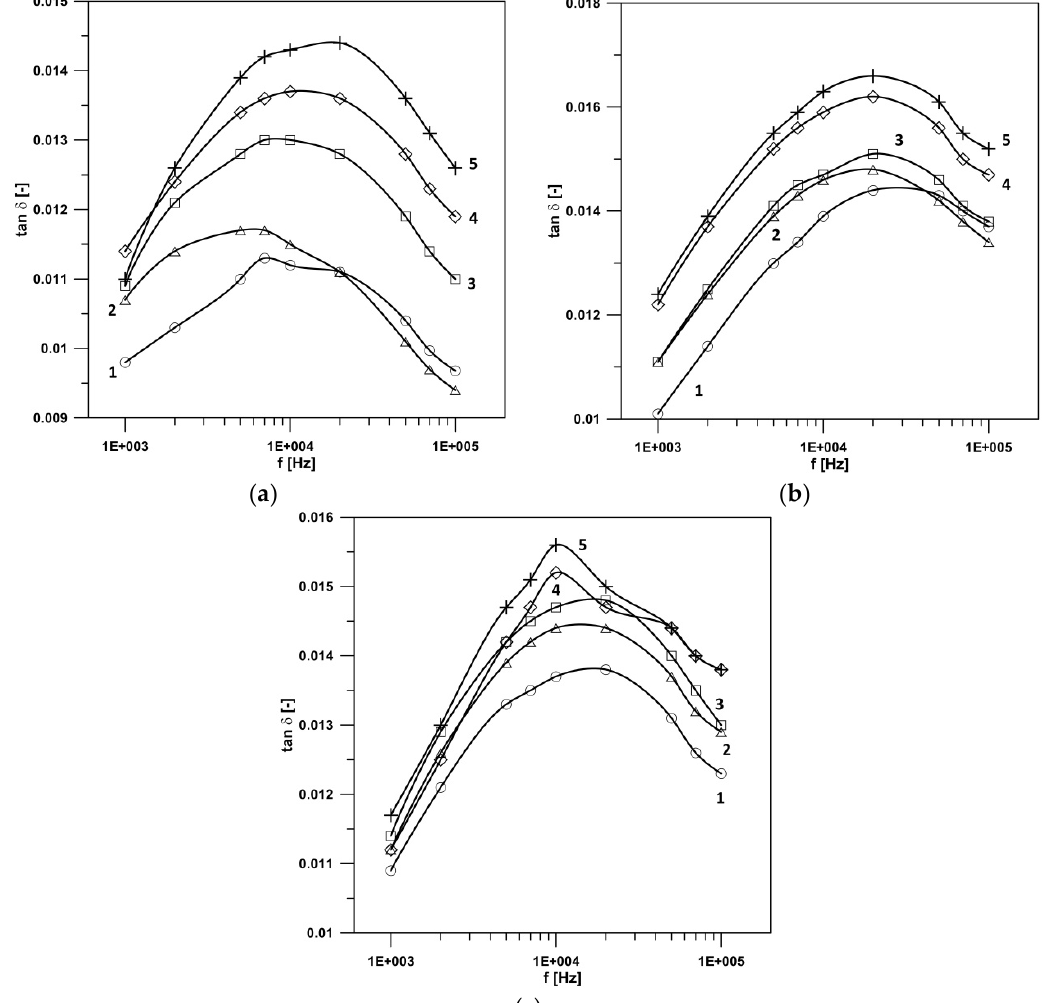
Figure 7. The influence of the impregnating liquid type on the characteristics of loss factor tan δ of the non-aged aramid insulation sample: ( a ) T = 40 °C, ( b ) T = 60 °C, ( c ) T = 80 °C, ( d ) T = 100 °C, 1—mineral oil, 2—synthetic ester, 3—natural ester.